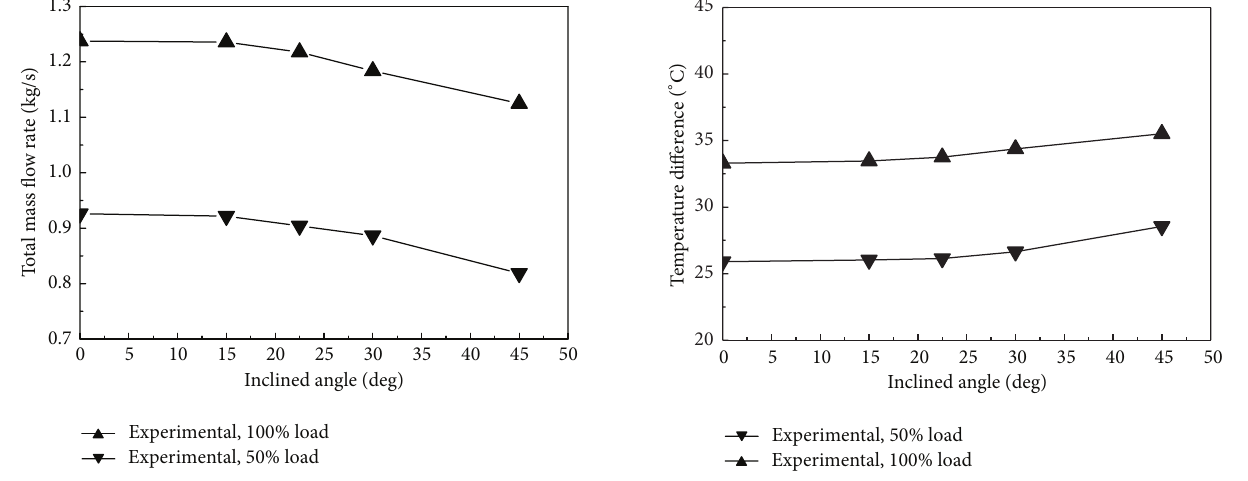
Figure 3: Average temperature differences under different inclined